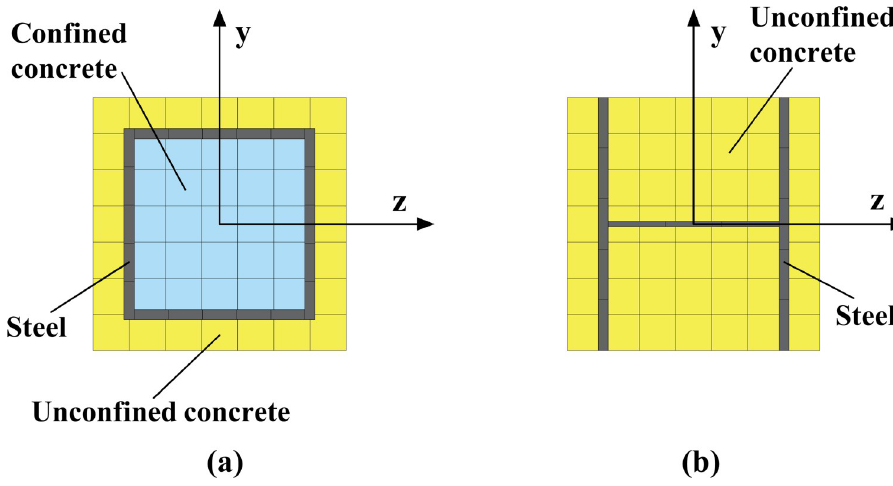
Fig 11. Diagram of fiber distribution. (a) Column section, (b) Sidewall